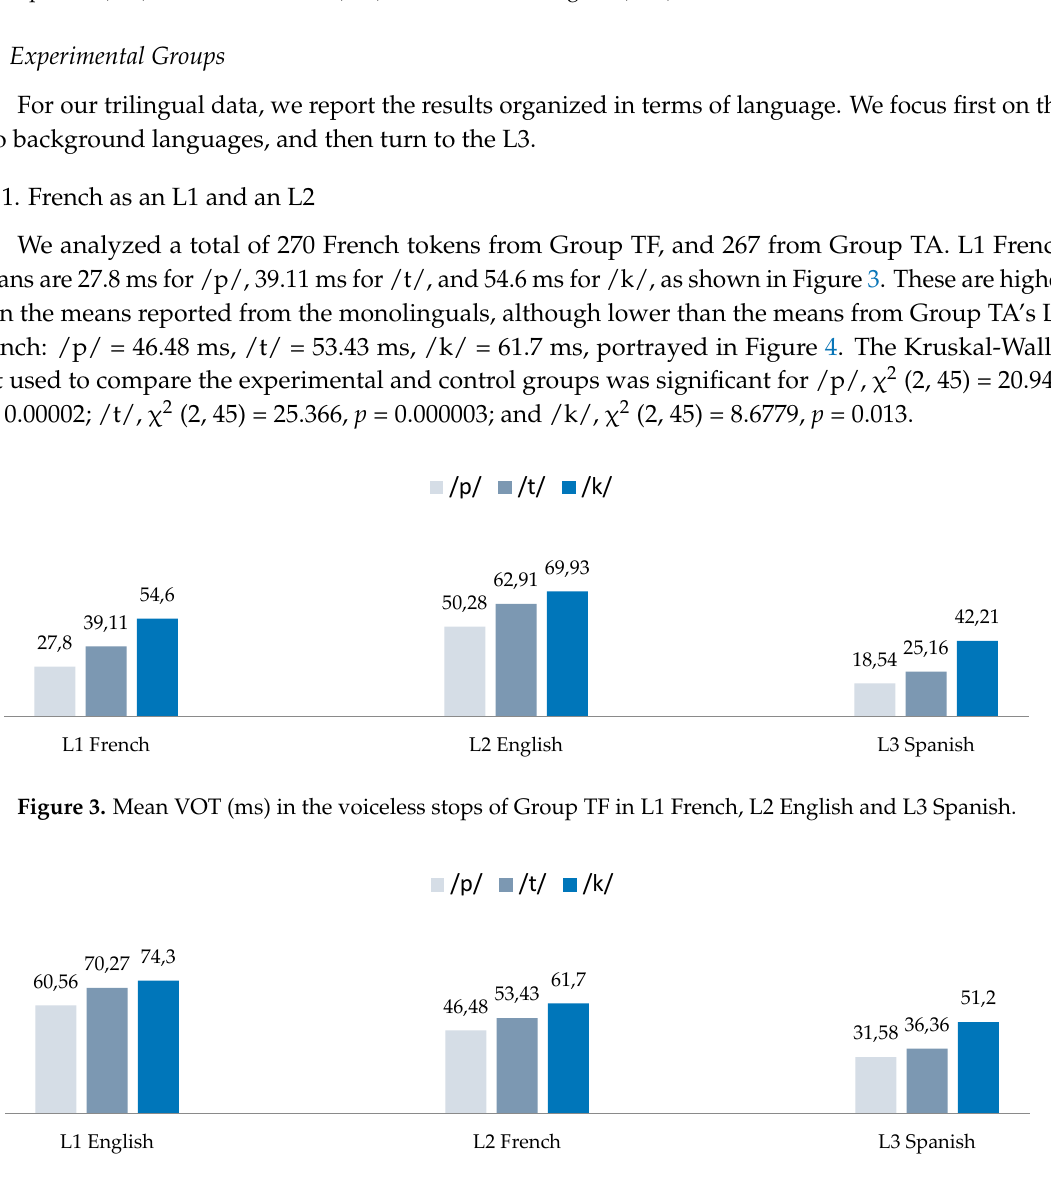
Figure 2. Mean Voice Onset Time (VOT) (ms) in the voiceless stops of monolingual speakers of Castilian Spanish (MS), Canadian French (MF), and Canadian English (MA).